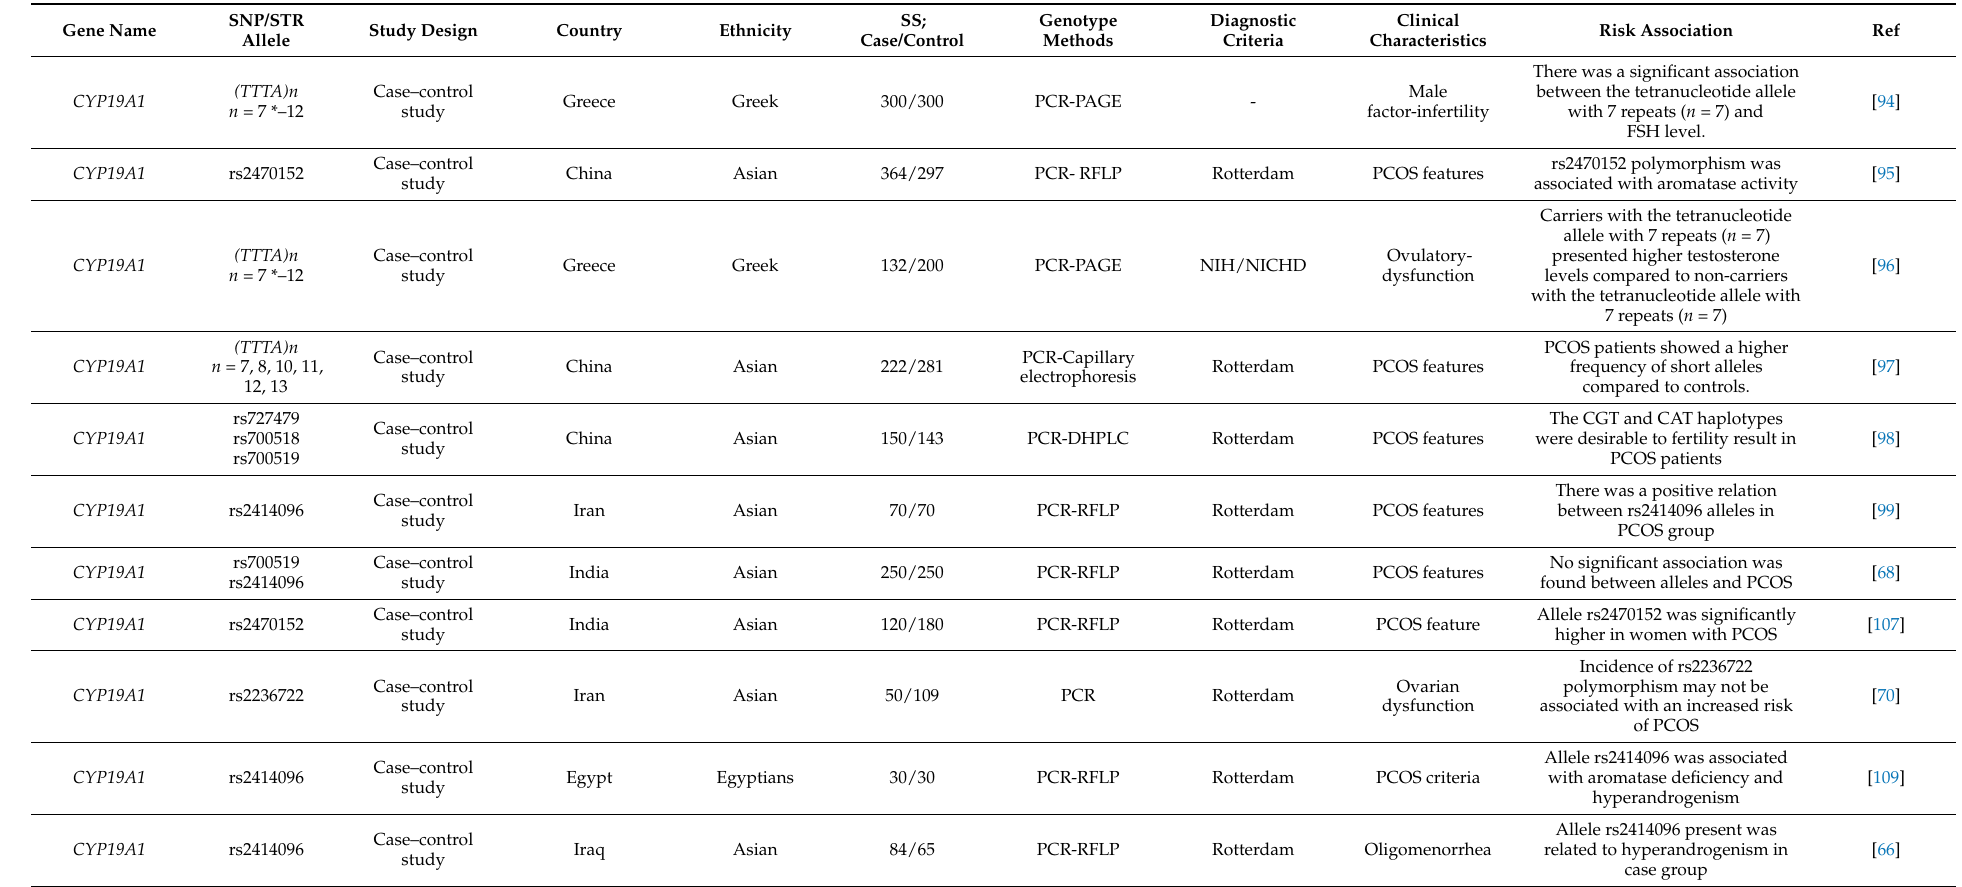
Table 3. Correlation between CYP19A1 genetic variants and PCOS with